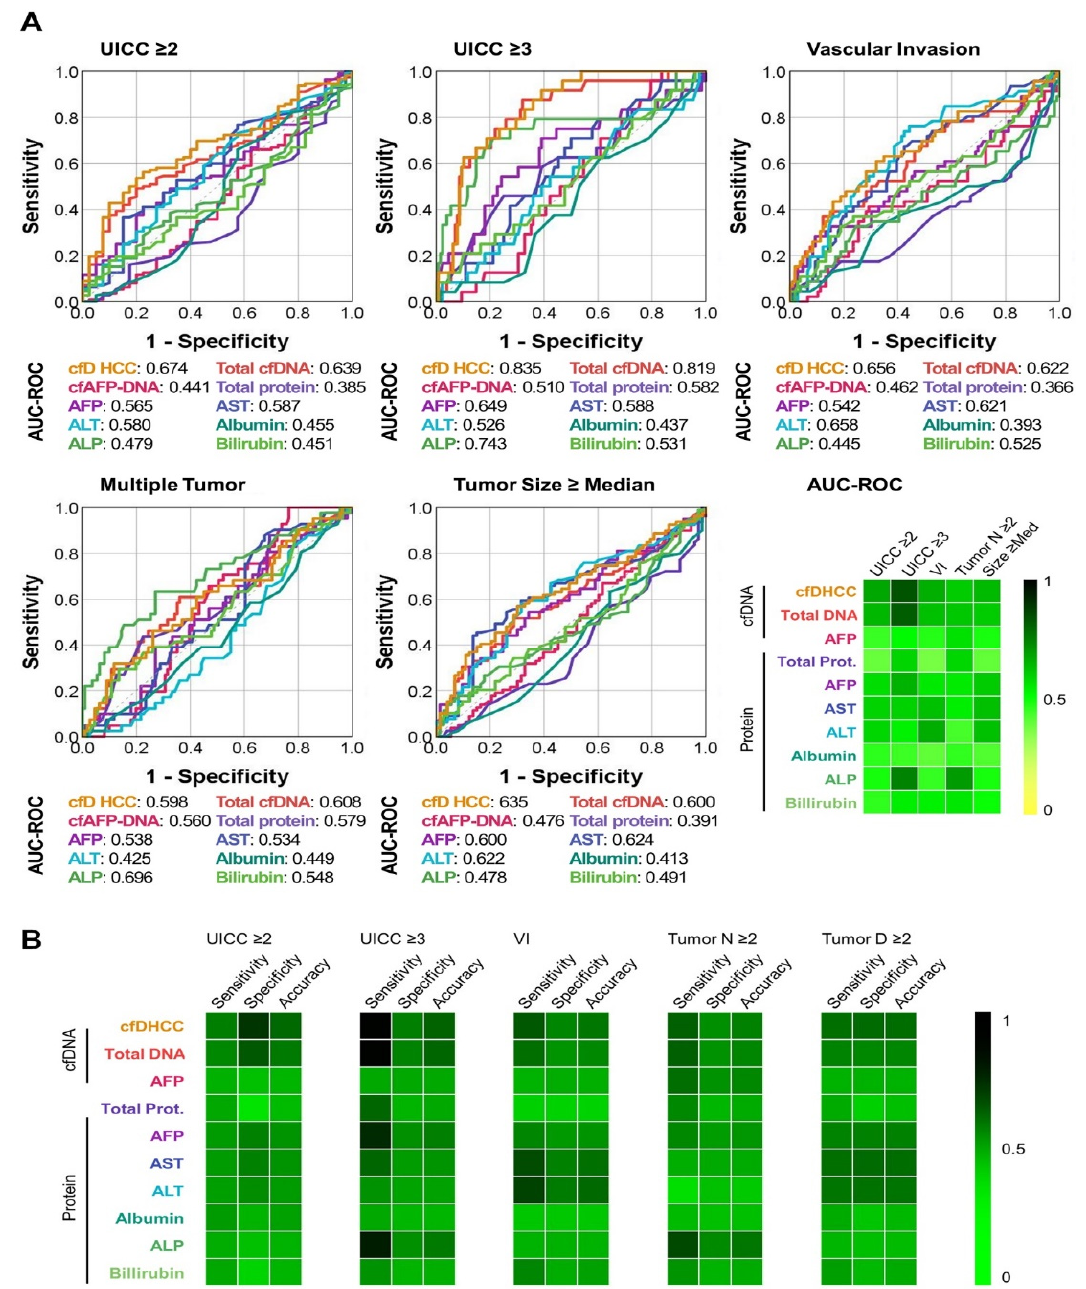
Figure 3. The clinical performance of cfDNA for determining the pathological features of HCC tu ‐ mors: ( A ) ROC curves for determining the UICC stages, existence of LVI, tumor size, and multifocality of a tumor. ( B ) Sensitivity, specificity, and accuracy of each biomarker for determining the UICC stages, existence of LVI, tumor size, and multifocality of a tumor.